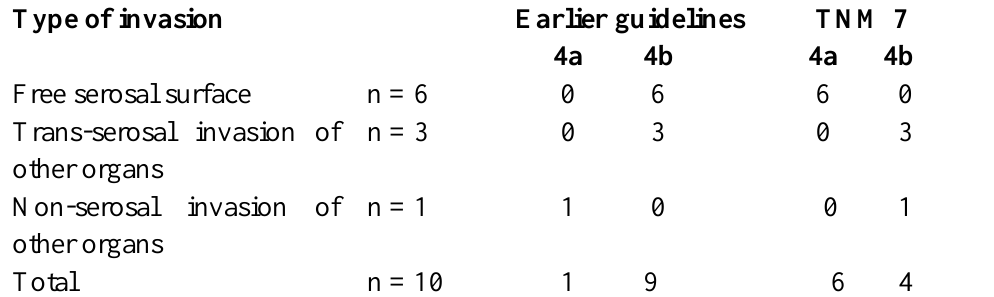
Table 1 . Comparison of pT4 substage distribution of earlier and revised TNM classifications for 10 hypothetical colorectal carcinomas showing invasion of the free serosal surface (n = 6), trans-serosal invasion of other organs or structures (n = 3), and non-serosal direct invasion of other organs or structures (n =